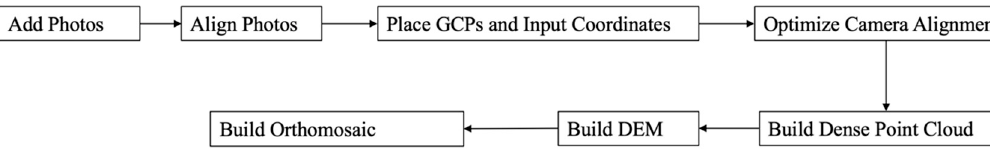
Figure 1. Workflow in Agisoft PhotoScan software.